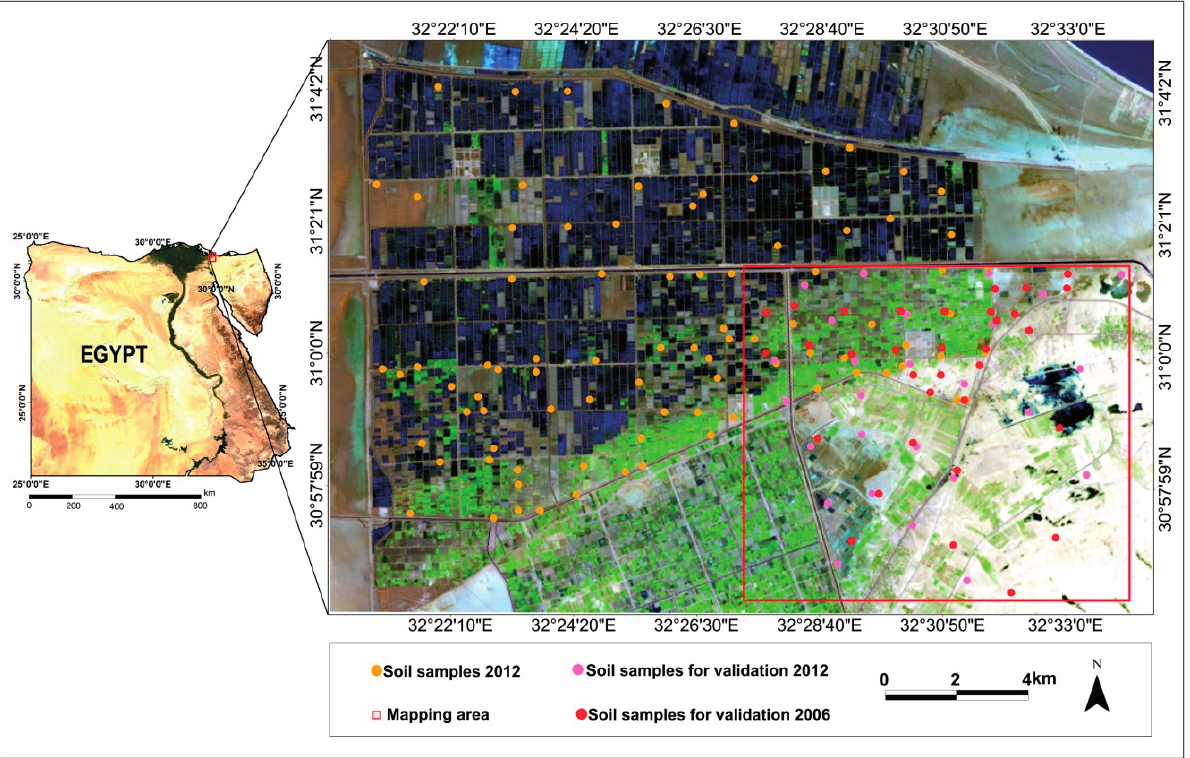
Figure 1. Study area shown in false color composite (RGB 742) of Landsat7 ETM+, 2012, and locations of soil sampling